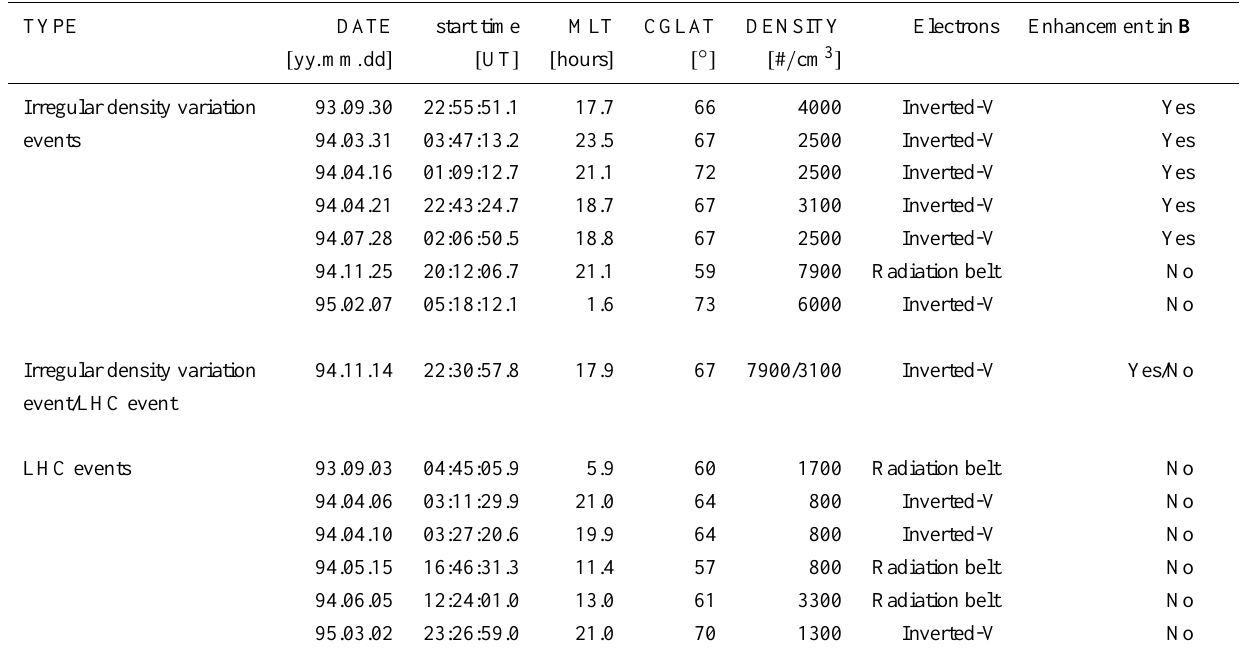
Table 1. Properties of detected irregular density variation events and LHC events. The densities are determined from the plasma frequency in all cases except one. In event 94.06.05 the density is determined from the f LH , where we assumed 95% O + and 5% H + . In the seventh column the energetic electrons are characterized. The events where the B -field is enhanced on the gradients of the density variations can be seen in the last column. Event 2 from 28 July 1994, is measured in a different burst mode than the rest, with two density signals, two E - and one B